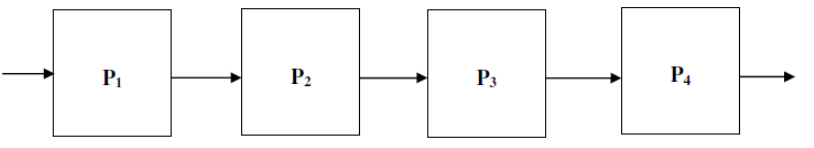
Figure 1. Block diagram of SWS with n =4, r =2 and w